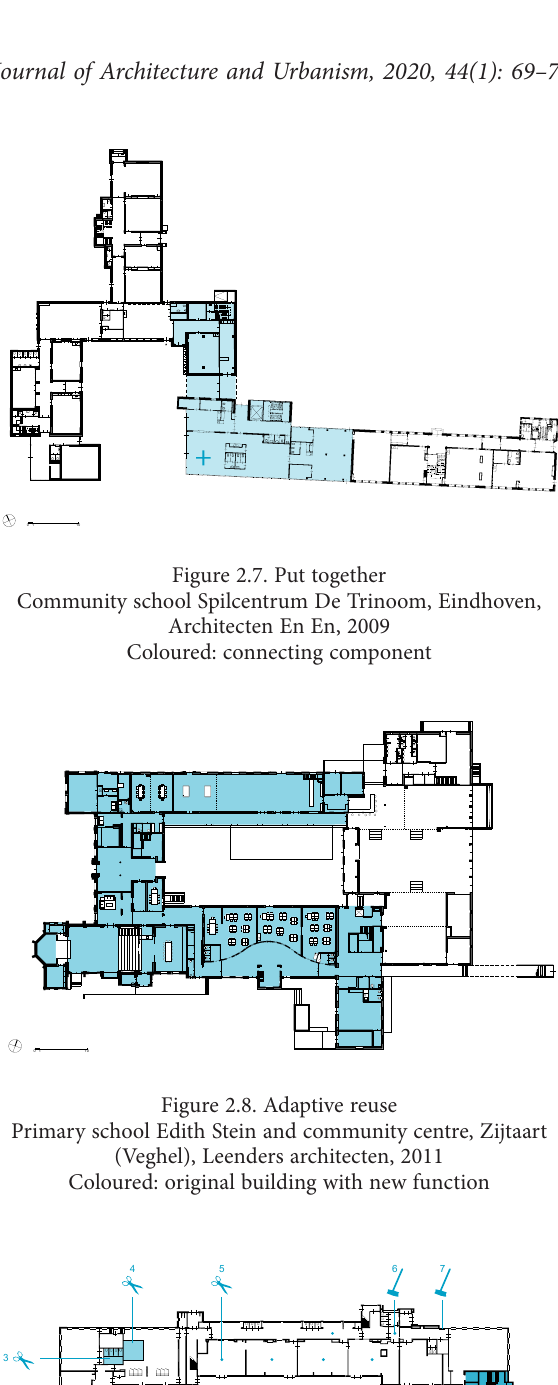
Table 2. Table of conversion strategies and the number of times